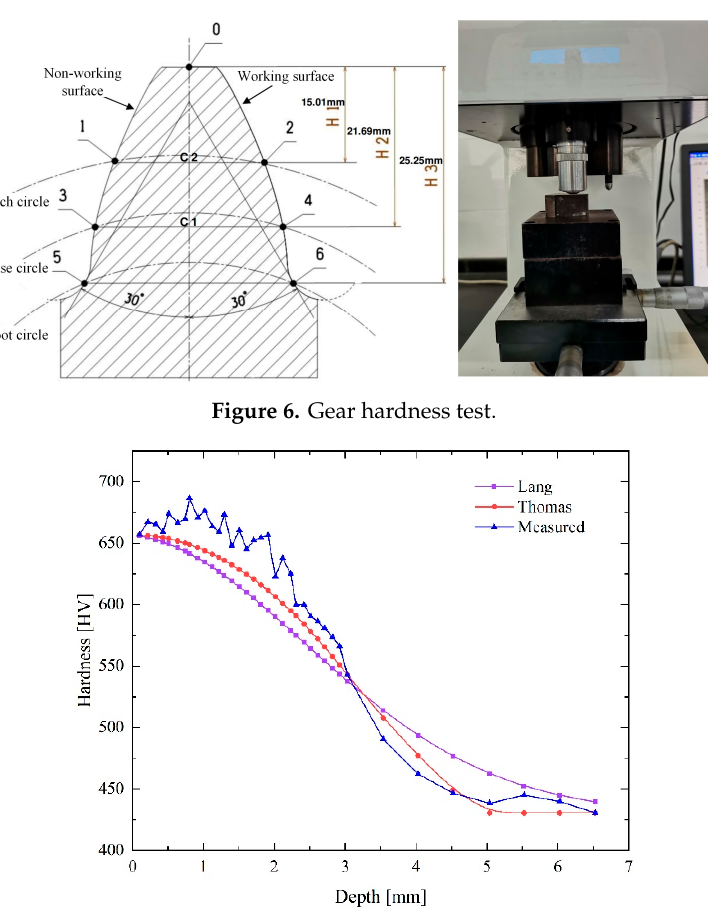
Figure 7. Comparison of empirical hardness curve with measured data.